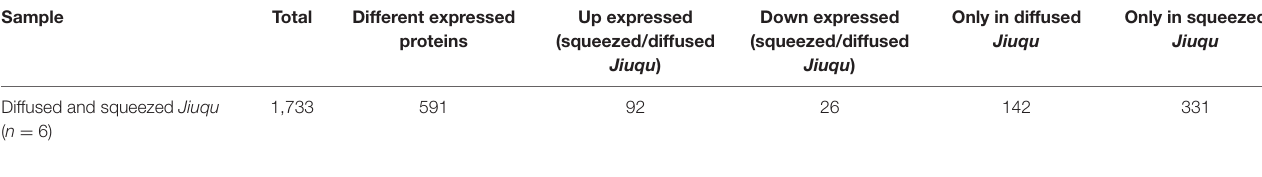
Up expressed Down expressed proteins (squeezed/diffused (squeezed/diffused Jiuqu ) Jiuqu )